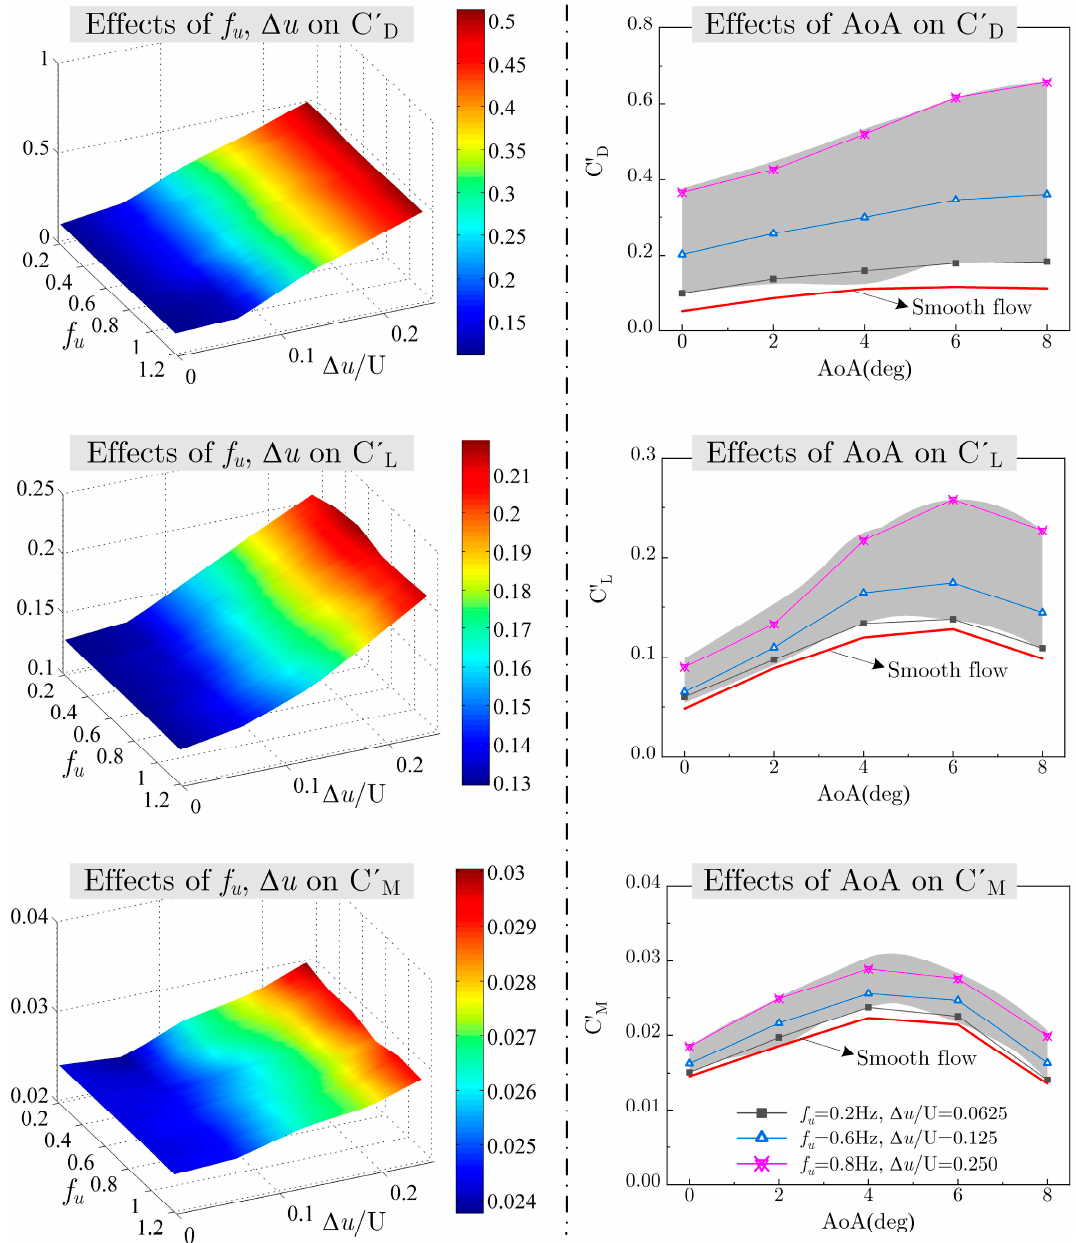
Figure 9. RMS values of C D , C L , and C M . The effects of f u and ∆ u /U (at AoA = 4 ◦ ) are shown in the left column, the effects of AoA are shown in the right column.